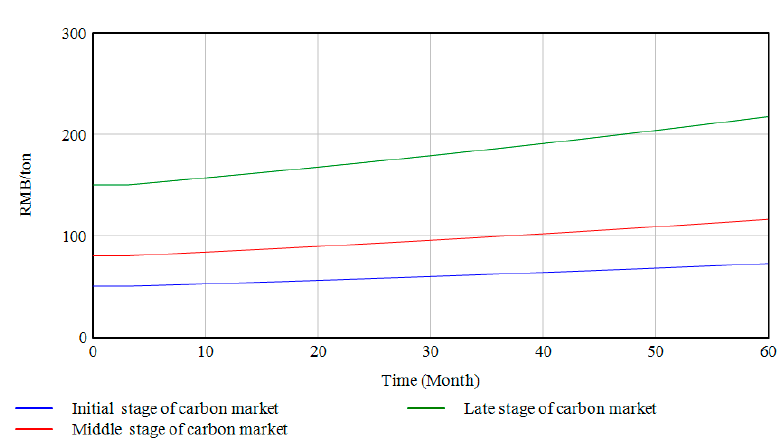
Figure 13. Trend of change in carbon price in three scenarios.